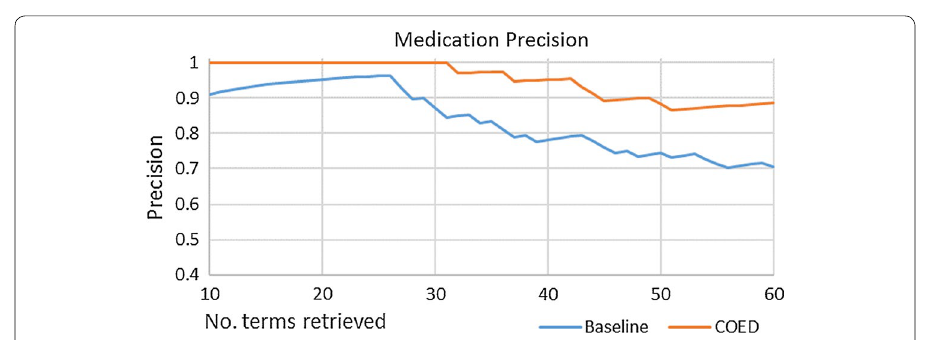
Fig. 14 Comparison of medication precision for baseline and COED